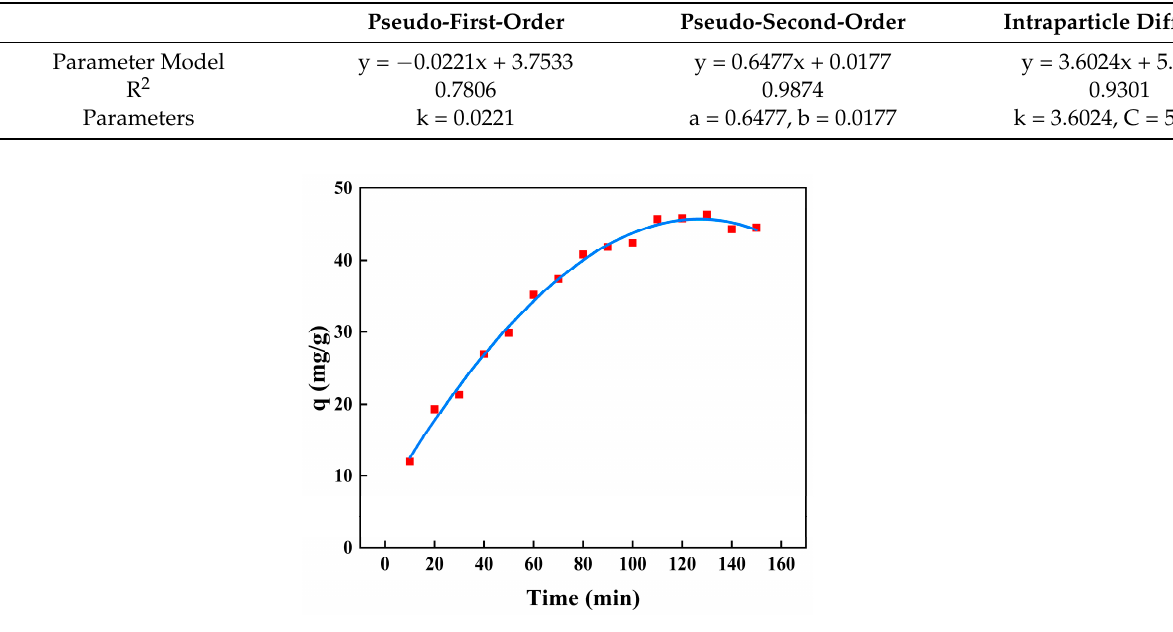
Figure 10. Kinetic adsorption model diagram. 2.7.3. Thermodynamic Adsorption thermodynamics for BSA removal using CS/ β -CDP composite membrane and the adsorption key parameters are tabulated in Table 8. The negative value of Δ G demonstrates the feasibility and spontaneous nature of the process [65]. Δ G gradually decreases with increasing temperature, indicating that the spontaneous degree of the reaction also increases [66]. The positive value of Δ H indicates that BSA adsorption on CS/ β -CDP composite membrane has an endothermic nature [67], and it is favored by temperature [68], which is similar to the previous report by Robert and colleagues [69]. Generally, if the heat of adsorption varies between 0 kj/mol and 20 kJ/mol, the process is physisorption, whereas higher energy (80 ∼ 200 kJ/mol) represents the chemisorption [70,71]. Intermediate values are related to systems wherein both interactions take place. The adsorption enthalpy of the CS/ β -CDP composite membrane for BSA was 66 kJ/mol, between 20 kJ/mol and 80 kJ/mol. Thus, the BSA adsorption process could be considered between physical adsorption and chemical adsorption and prefer chemical adsorption. The results implied good agreement with FT-IR and XRD. The positive value of Δ S suggests that the entropy of this adsorption system is increased [72], indicating increased randomness at the solid/solution interface with an affinity of the CS/ β -CDP composite membrane for BSA. Moreover, it corresponds to an increase in the degree of freedom of the adsorbed species and reflects that the distribution of BSA adsorbed on the membrane was more chaotic than that in the aqueous solution, which could be due to a combination of adsorbent with BSA [43].